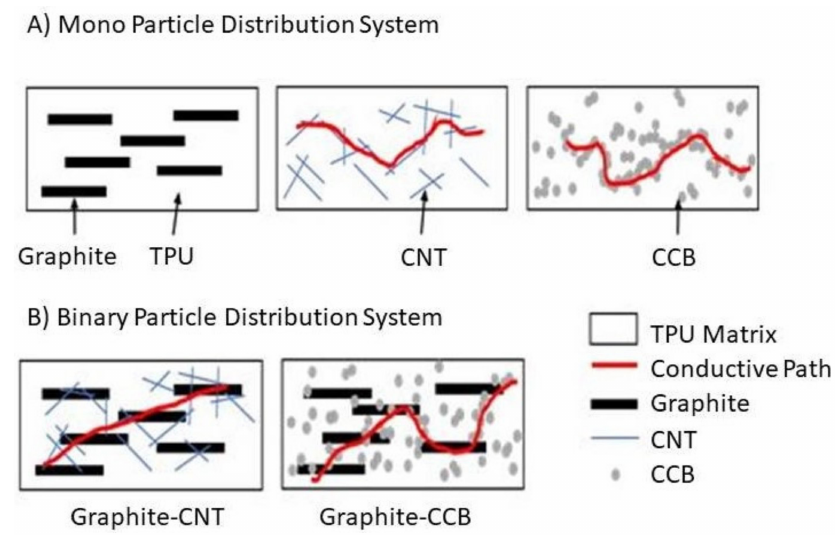
Figure 4. Conceptual diagram of electrical conductivity by particle dispersion or distribution, ( A ) mono- particle dispersion, ( B ) binary particle dispersion.